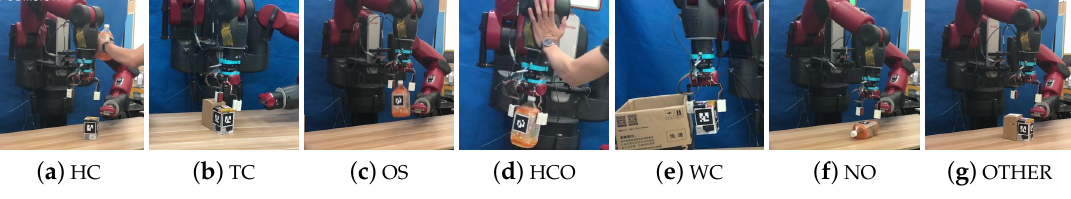
Figure 5. Seven representative unexpected anomalies in the kitting experiment (left-to-right): ( a ) Human Collision (HC), ( b ) Tool Collision (TC), ( c ) Object Slip (OS), ( d ) Human Collision with Object (HCO), ( e ) Wall Collision (WC), ( f ) No Object (NO), ( g ) Other